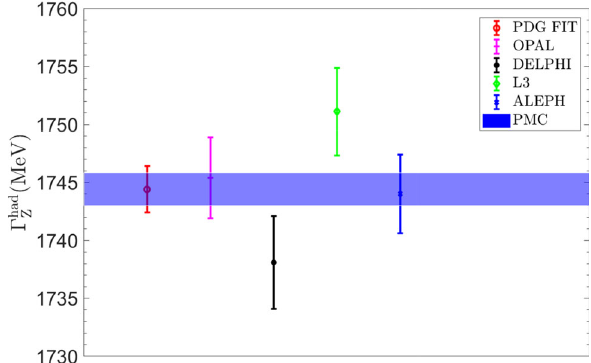
Fig. 3 The PMC prediction of the Z -boson hadronic decay in com- parison with the experimental values given by the PDG global fit of experimental data [71], and by the OPAL [82], DELPHI [83], L3 [84], and ALEPH [85]